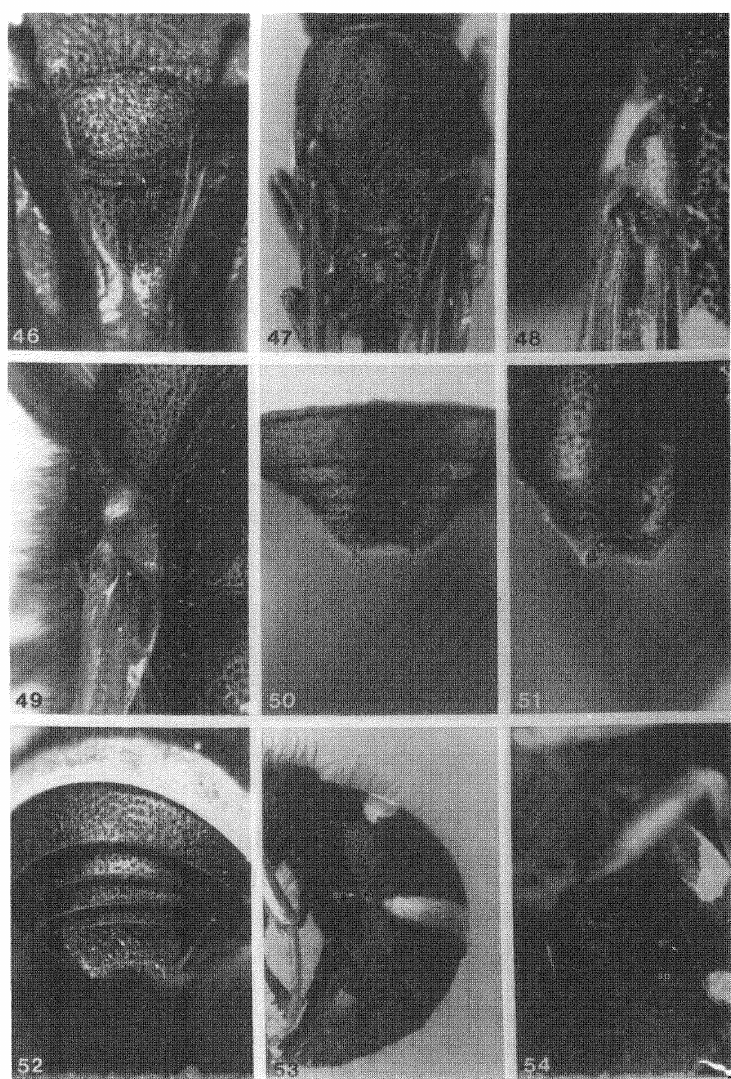
Figs. 46--54. 46. Paramasaris richardsi, 14. Dorsal view of scutellum and metanotum. 47 P. cupreus, 13X. Dorsal view of mesosoma. 48-49. Tegula. 48. Gayella araucana, 21X. 49. G. reedi,. 15. 50--52. Dorsal view of